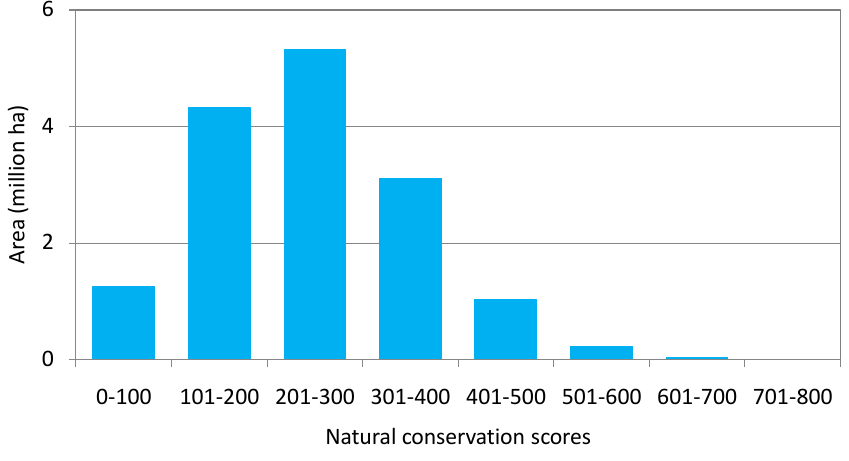
Figure 1. Distribution of areas potentially available for intensive forest management (IFM) in nature conservation score classes (nature conservation scores are positively correlated with nature conservation